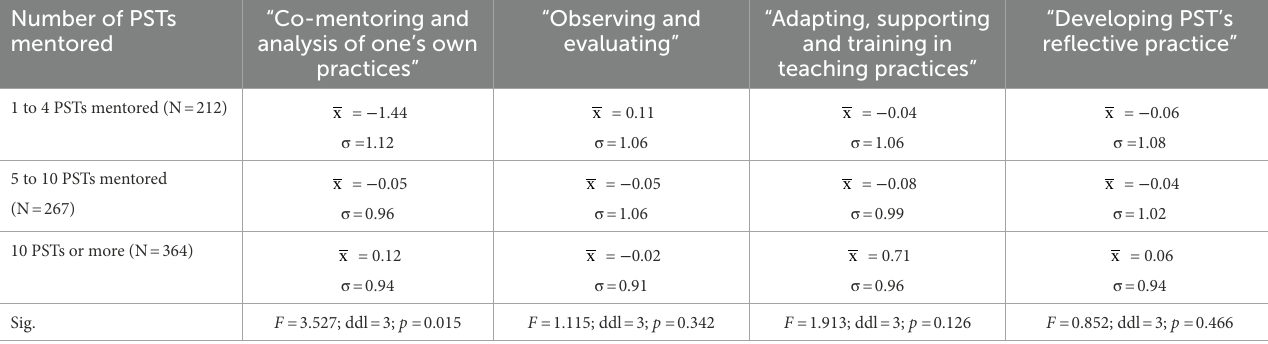
TABLE 7 Means, for each factor, of respondents divided into 3 subgroups according to the number of PSTs mentored. Number of PSTs